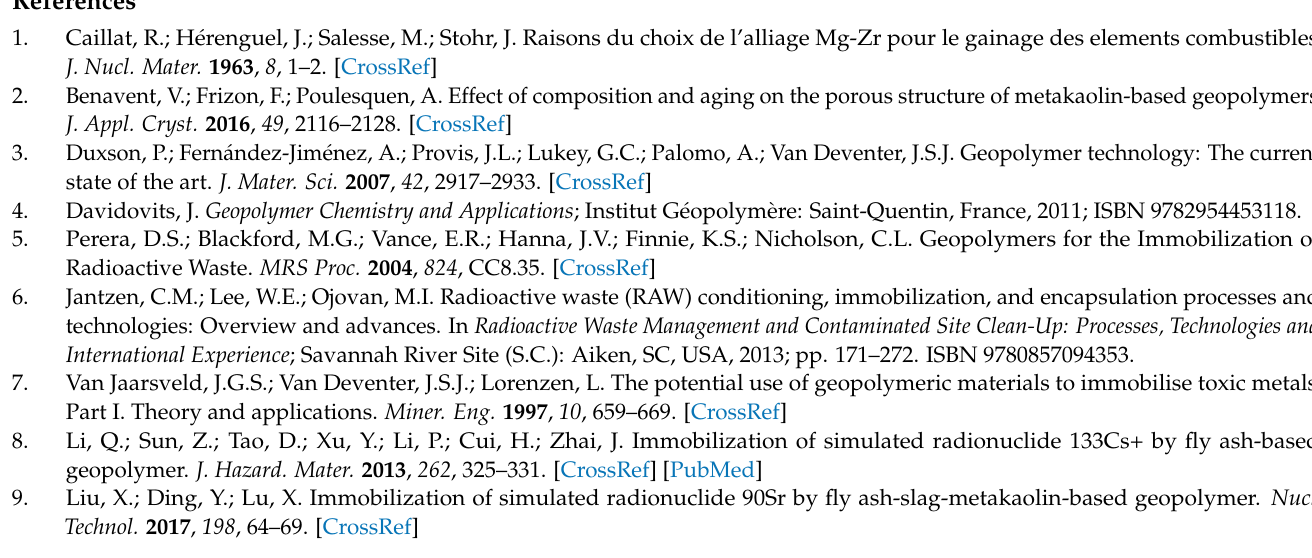
Table S1: Summary of the results obtained by statistical analysis of dataset from image